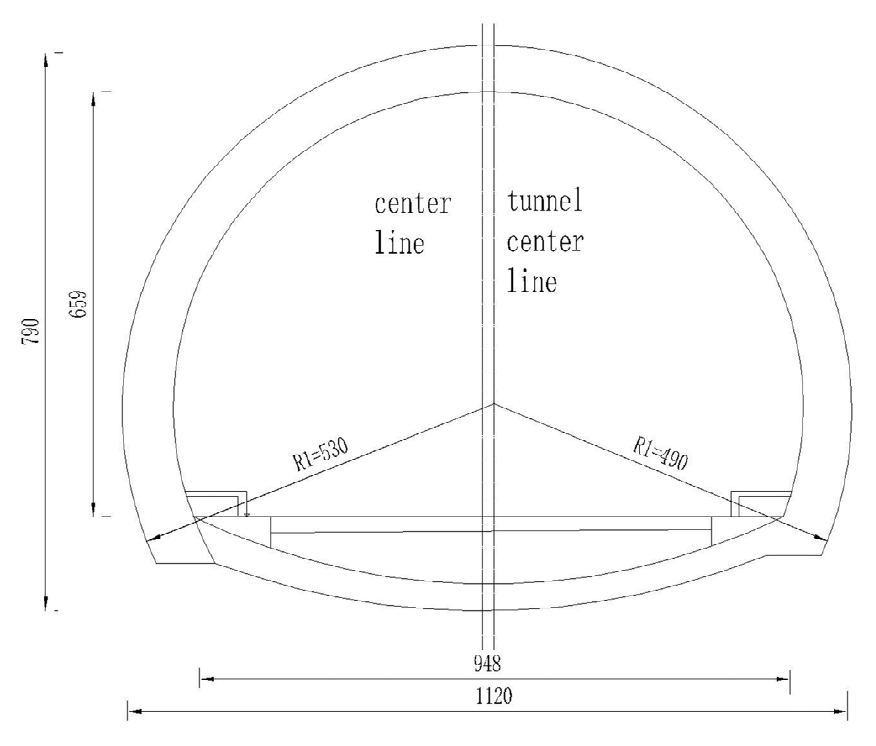
Figure 1. Layout of tunnel dimensions (unit: cm).